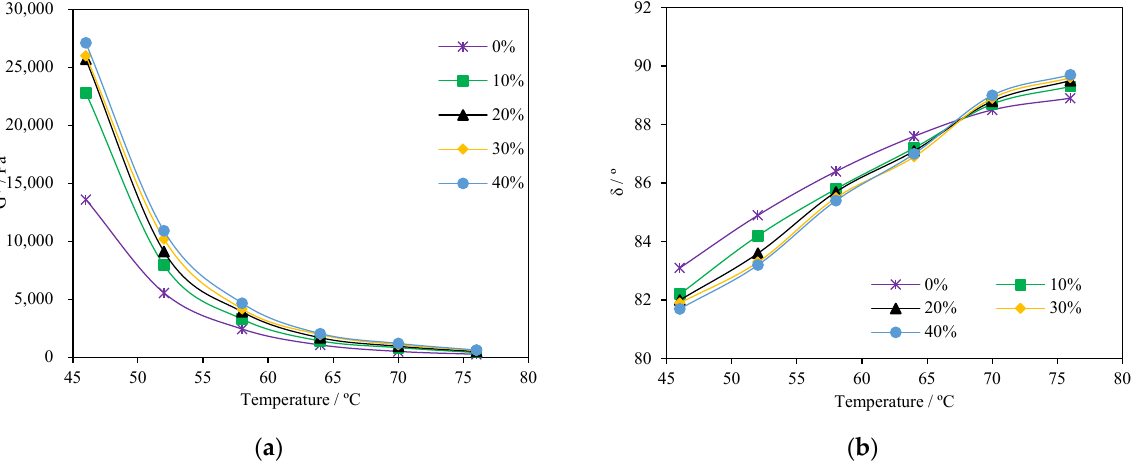
Figure 7. Dynamic rheology properties of asphalt with different PCB-NMF content: ( a ) dynamic shear module G*; ( b ) phase angle δ .